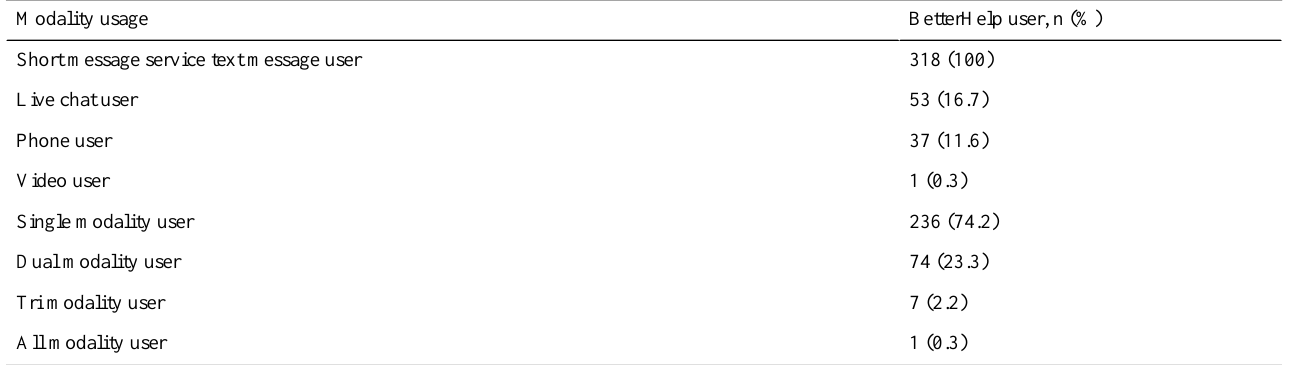
Table 3. Modality usage of BetterHelp